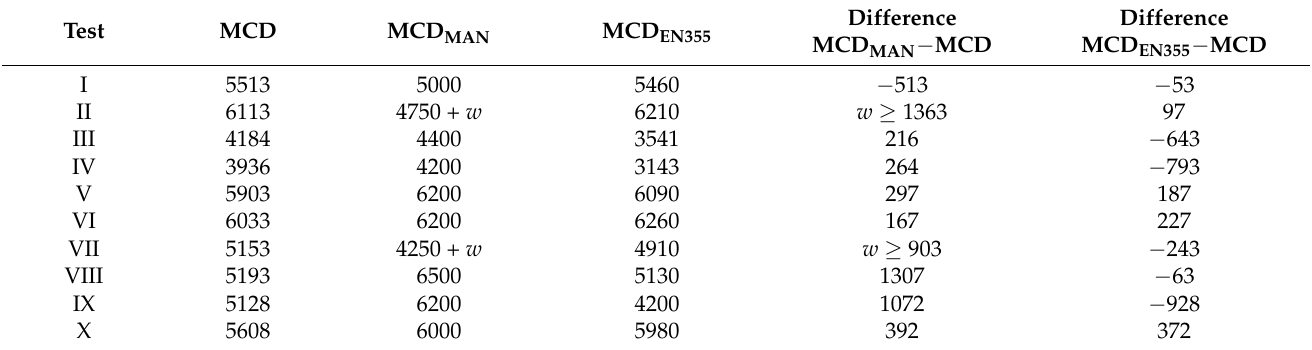
Table 8. Minimum clearance distance